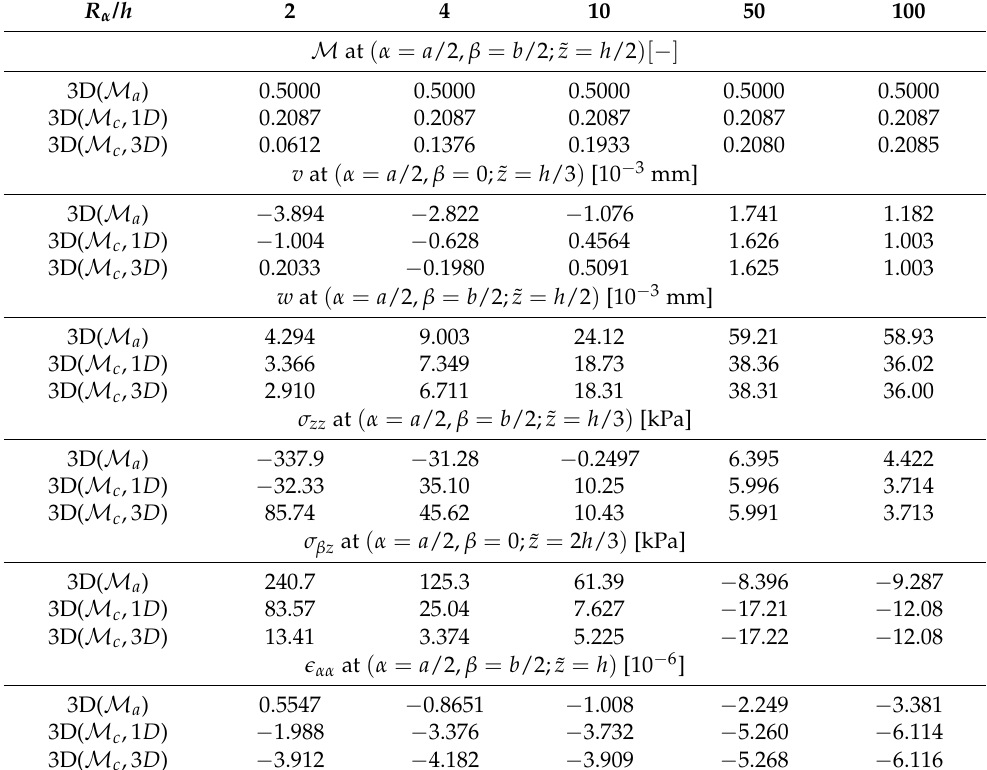
Table 8. Fourth benchmark, sandwich spherical shell panel with an FGM core subject to an external moisture content applied to the top and bottom surfaces. The results of all the 3D models consider N = 3 and NL =